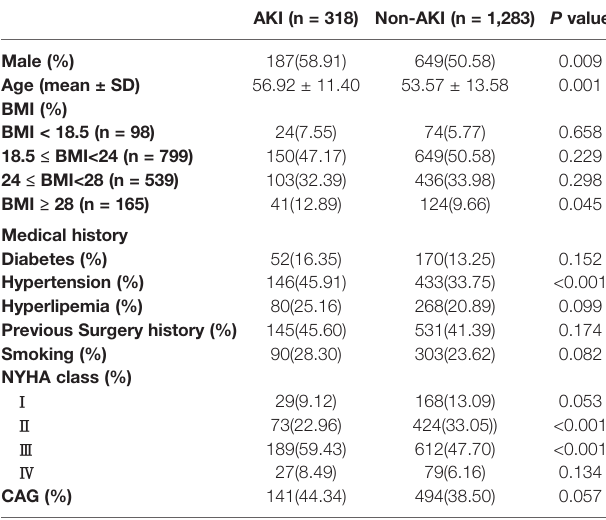
TABLE 1 | Baseline characteristics of subjects.